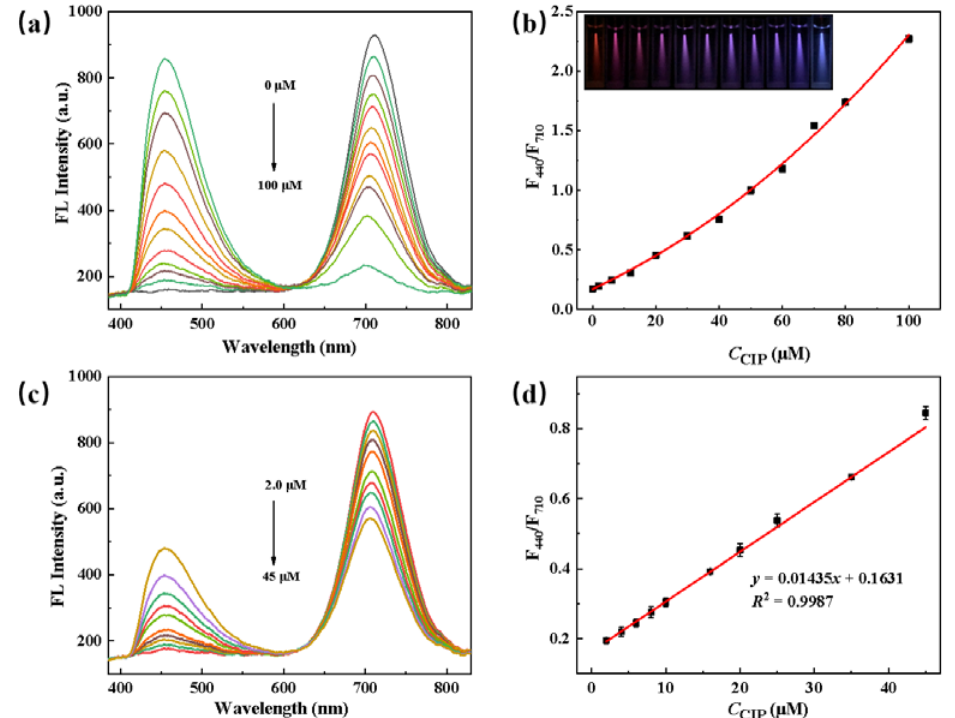
Figure 6. ( a ) Fluorescent emission spectra of RFFS/GMPA@CdTe-QDs in the different concentrations of CIP (0–100 μM) solution; ( b ) the linear relationship between F 440 /F 710 and the concentration of CIP in the range of 0 to 100 μM (insert: picture under LED light); ( c ) fluorescent emission spectra of RFFS/GMPA@CdTe-QDs in the different concentrations of CIP (0–45 μM) solution; ( d ) the linear relationship between F 440 /F 710 and the concentration of CIP in the range of 0 to 45 μM.